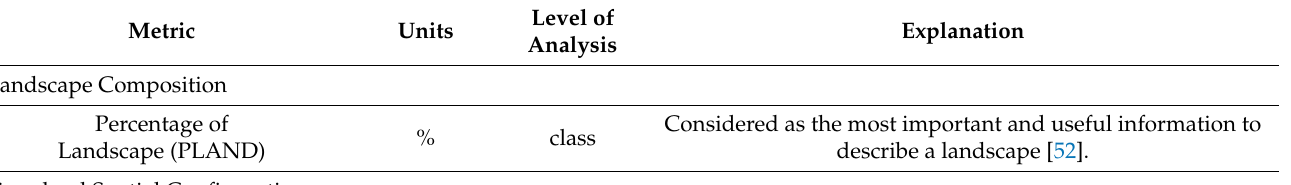
Table 1. Landscape metrics selected to better reflect the Aguapey VGA’s composition and the grassland